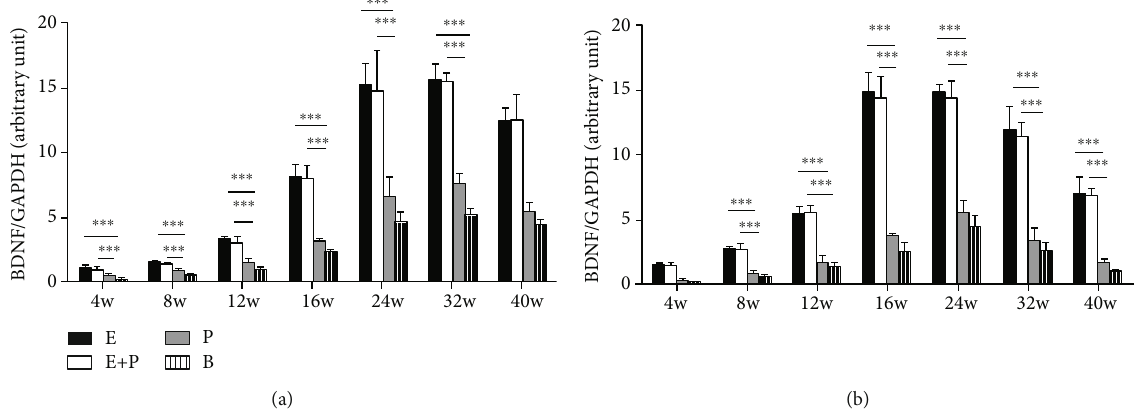
Figure 6: RT-PCR analysis of BDNF gene fold change levels (normalized to GAPDH) in di ff erent groups. E: entire root group; E+P: entire root+posterior division group; P: posterior division group; B: blank control group. (a) Left hemisphere; (b) right hemisphere. ∗∗∗ P < 0 : 001 . Data are expressed as mean ± SD (one-way ANOVA followed by